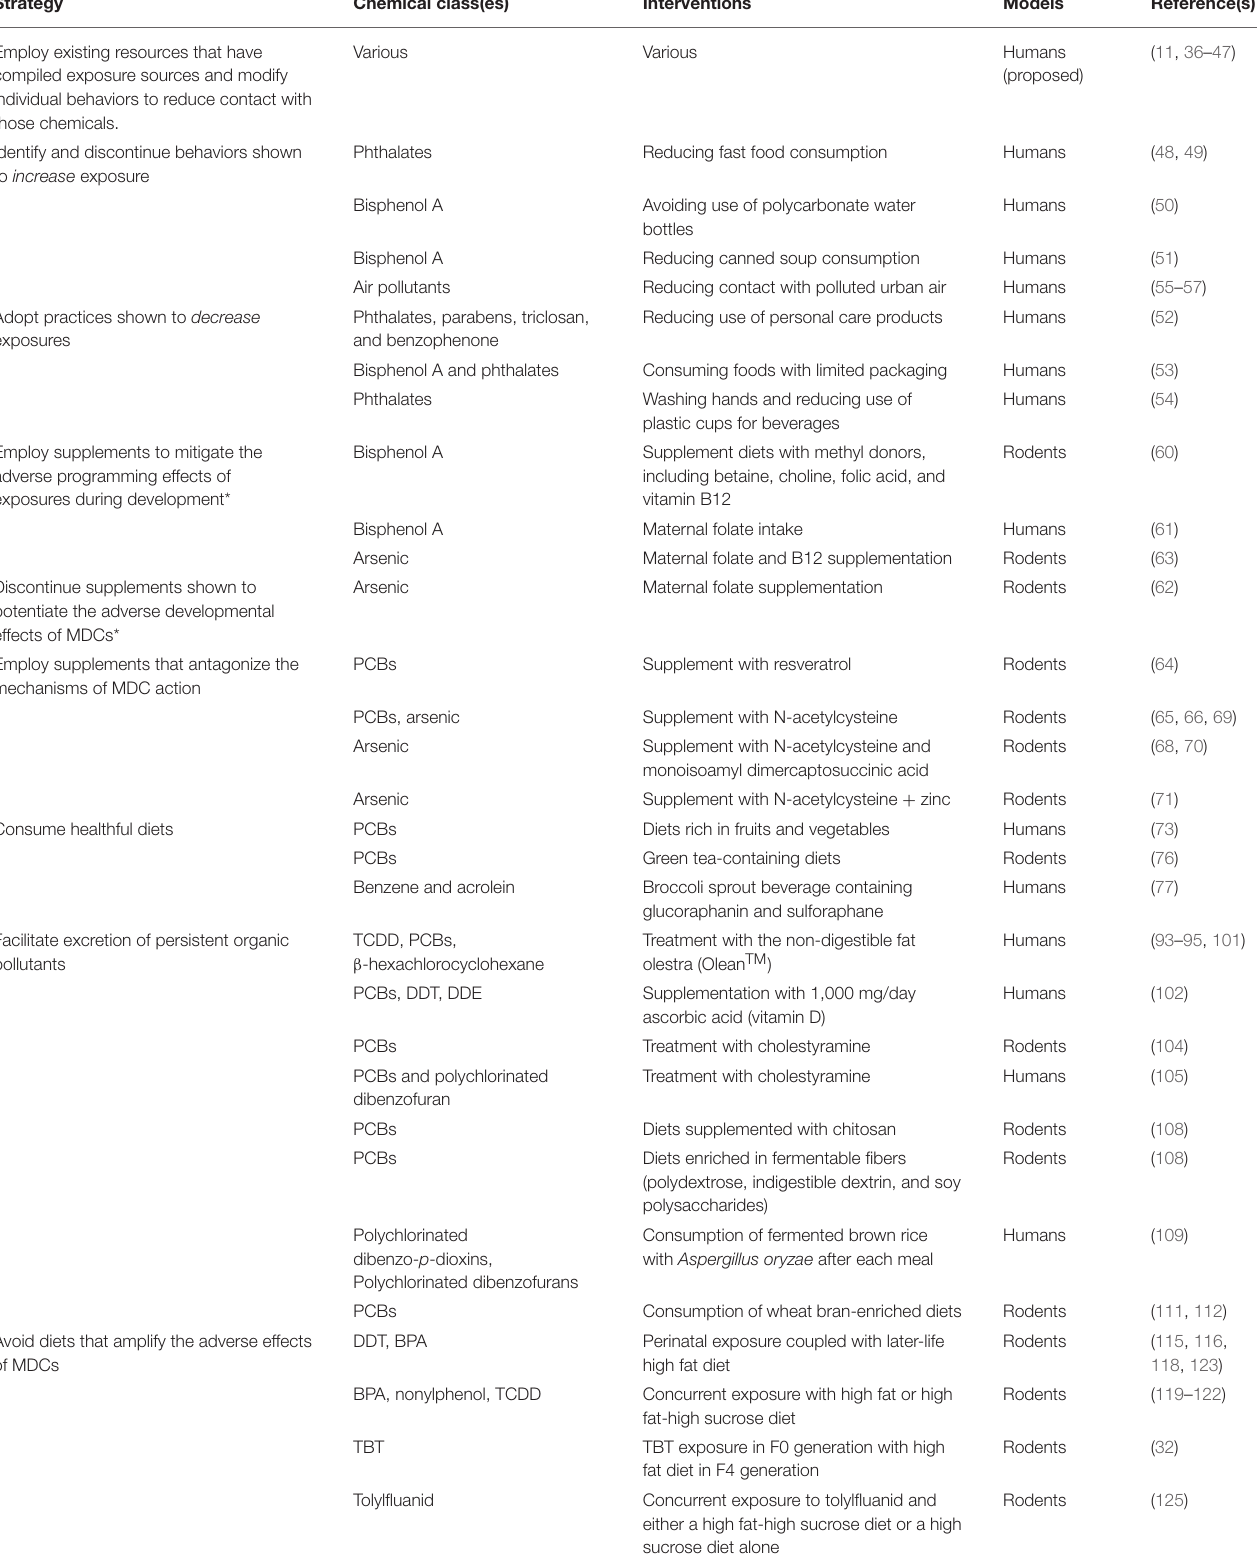
TABLE 2 | Potential intervention strategies to reduce the deleterious effects of metabolism-disrupting chemicals.